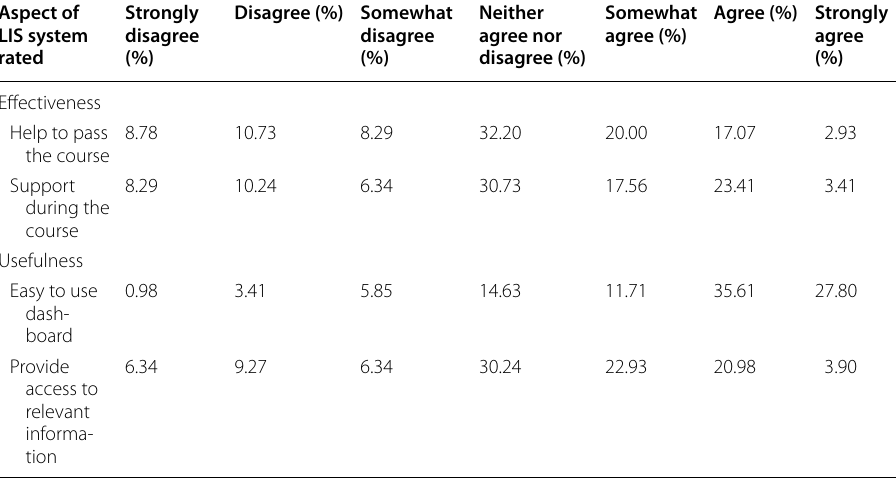
Participants (n 205) = Table 12 Results when asking about feedback, dashboard, and LIS system globally Aspect of LIS system